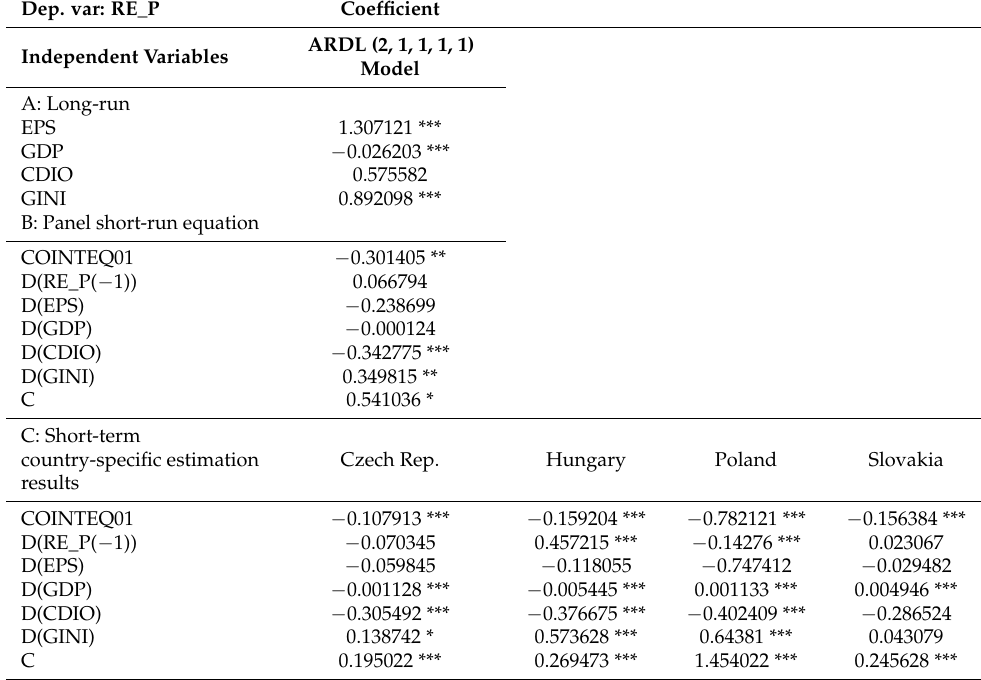
Table 16. Long-run and short-run coefficients for model 1.